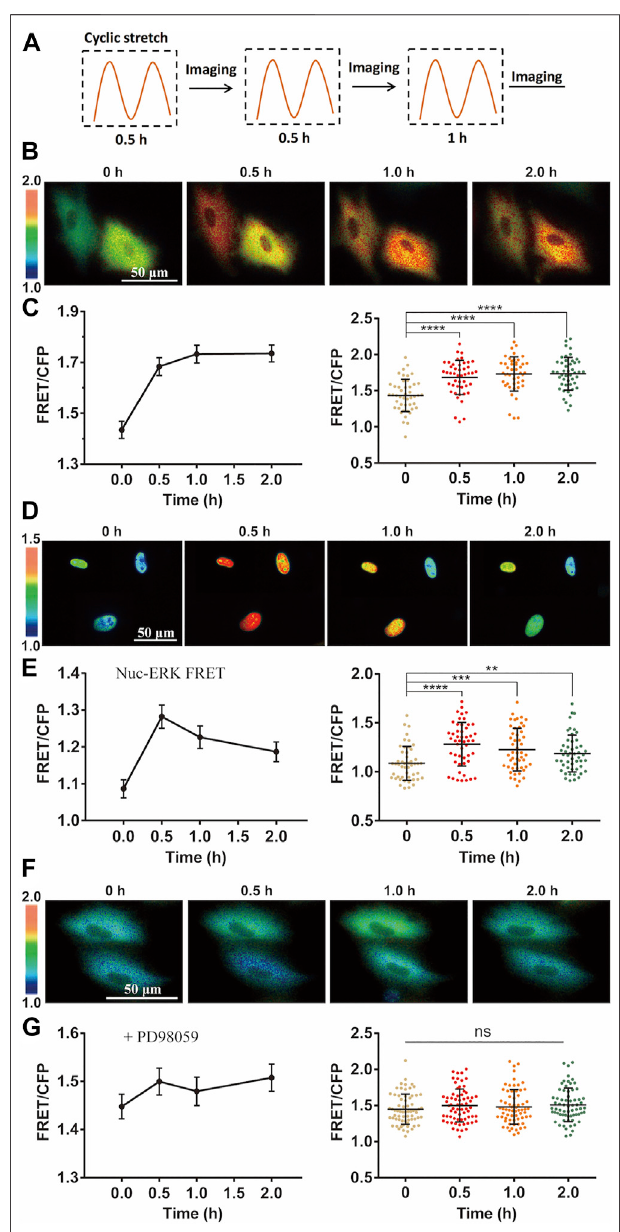
FIGURE 2 | Cyclic stretch-induced ERK activation by FRET measurements. FRET/ECFP emission ratiometric images show the activation of ERK by cyclic stretch in ASM cells pre-incubated in 1% FBS culture medium. Scale bar = 50 µm. (A) Illustrated experimental procedures of cyclic stretch stimulation (with a 0.5-Hz sinusoidal curve at 12% elongation deformation) followed by FRET imaging in multiple cycles. (B,C) ERK FRET ratio (YPet/ECFP) images (B) , and quanti fi cations of the FRET changes in curves(Mean±S.E.M.)andscatteringdots(Mean±S.D. n =46) (C) aftercells were stimulated with cyclic stretch for the indicated time. (D,E) FRET images with Nuc-ERK FRET biosensor in cells (D) , and their statistical quanti fi cations ( n = 50) (E) after cyclic stretch at the indicated time points. (F,G) ERK FRET images (E) and FRET statistical quanti fi cations ( n = 67) (G) in cells pre-treated with 10 µM PD98059 inhibitor for 1 h. Student ’ s t-test was performed betweenthecontrolandoneexperimentalgroup,andmultipleroundsoft-test ( Continued )